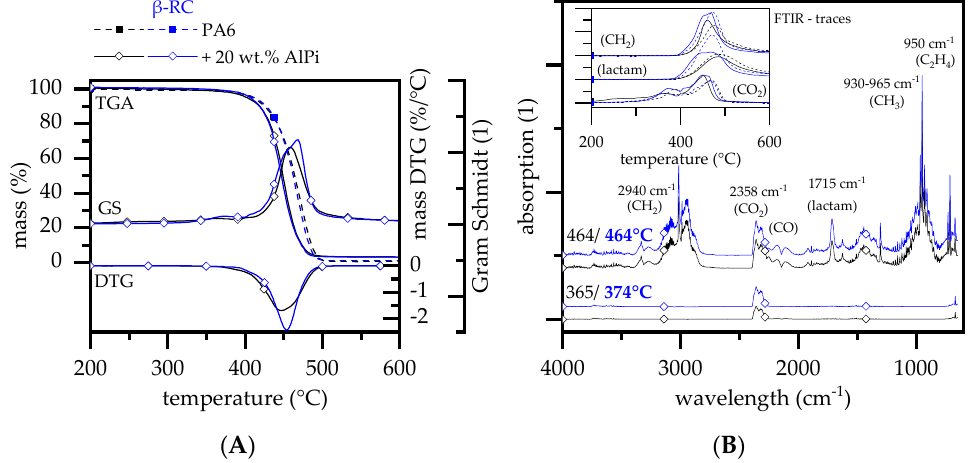
Figure 5. TGA, DTG, Gram Schmidt and FTIR (Gas) curves determined at a heating rate of 20 K/min. ( A ) TGA, DTG Gram Schmidt for PA6 containing 20 wt.% AlPi; ( B ) corresponding FTIR peak spectra.